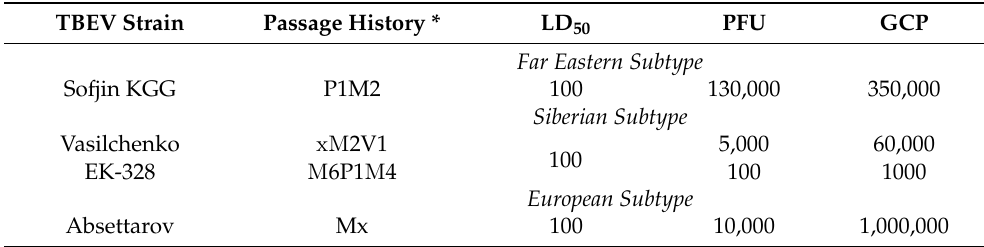
Table 2. Amounts of GCP and PFU per 100 LD 50 of different TBEV